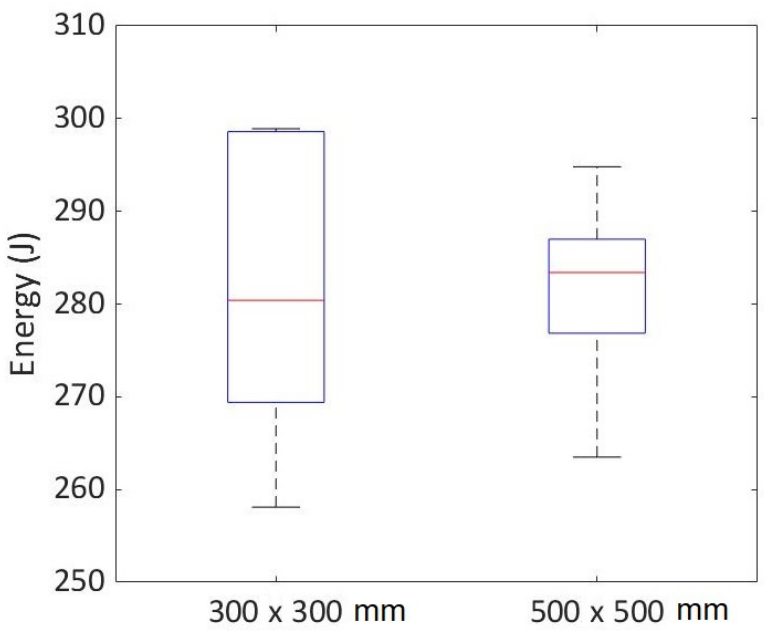
Figure 8. Energy loss in the two test conditions.